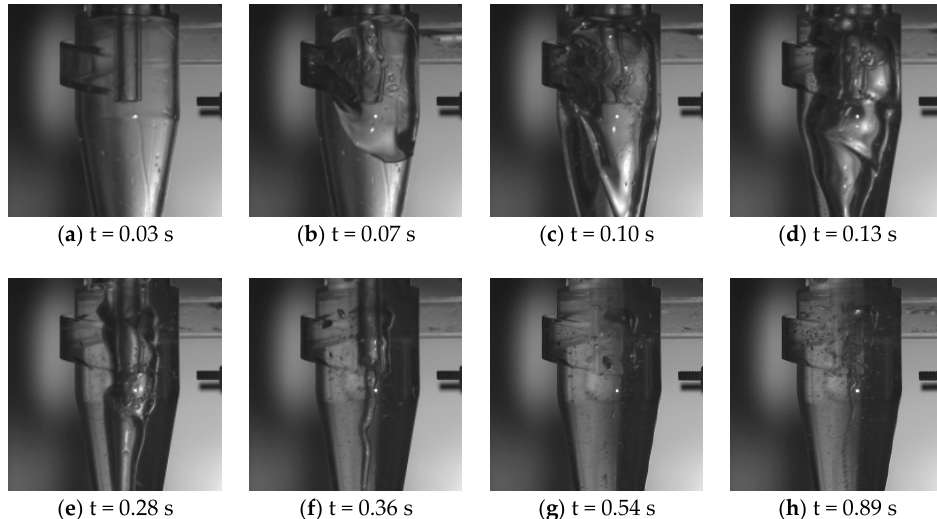
Figure 15. Bubble flow process in spiral inlet cyclone.